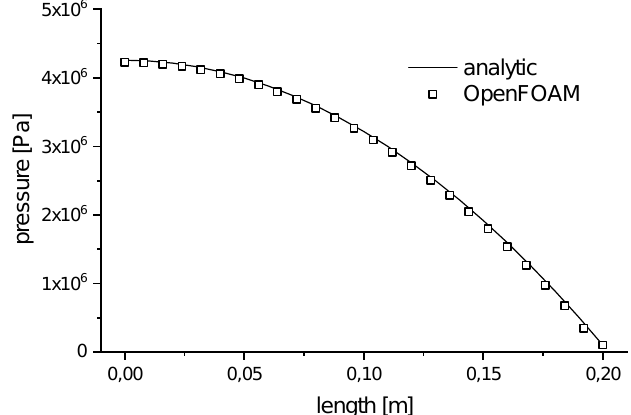
Figure 7. Pressure distribution in the x-direction in the plate at the end of the compression step with a filling up to 0.2